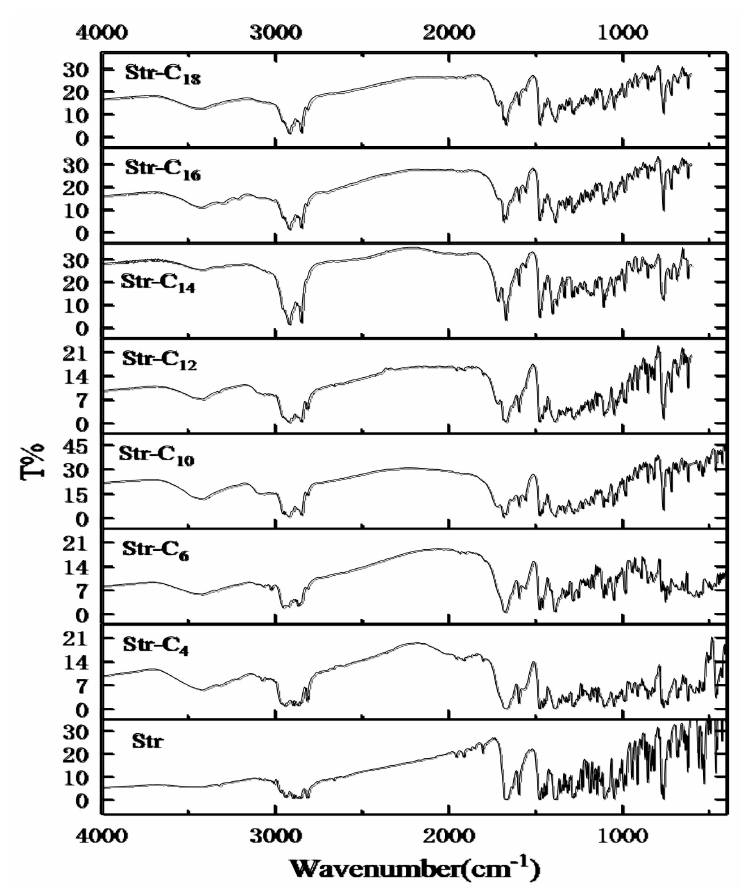
Figure 3. The FTIR spectra of Str and its ion-pair compounds.